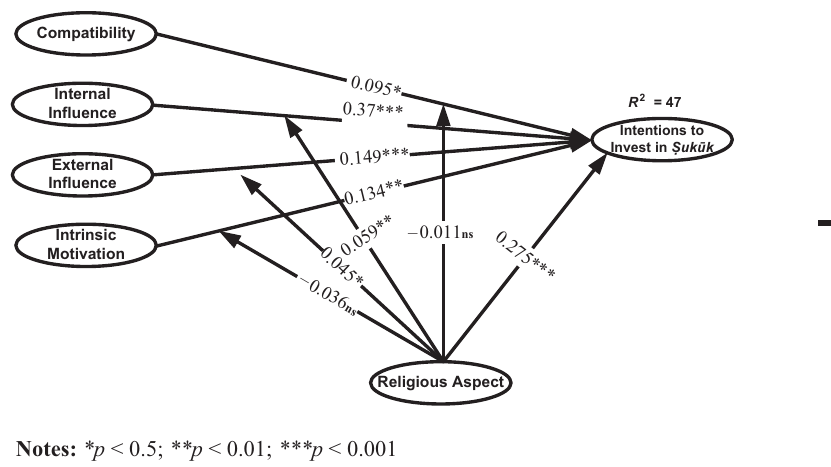
Figure 2. Model with results